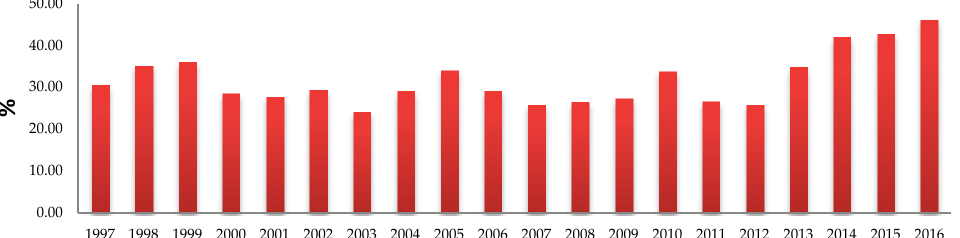
Figure 6. Share of renewables in electricity production (%), worldwide evolution, Source: Own representation based on Enerdata [23].